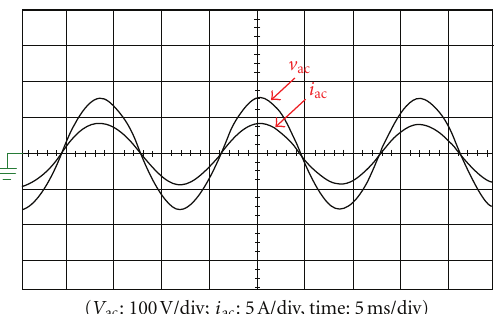
Figure 16: Measured ac output voltage and current waveforms of